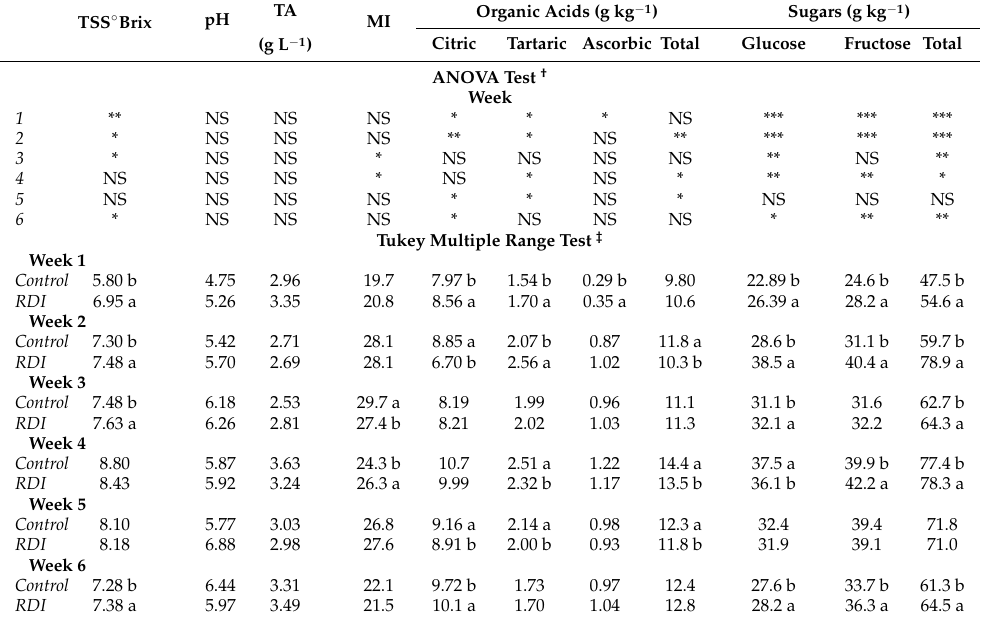
Table 3. Total soluble solids (TSS, ◦ Brix), pH, titratable acidity (TA, g L − 1 ), maturity index (MI), and content (g kg − 1 ) of organic acids and sugars in the cherry tomatoes as affected by irrigation treatment and